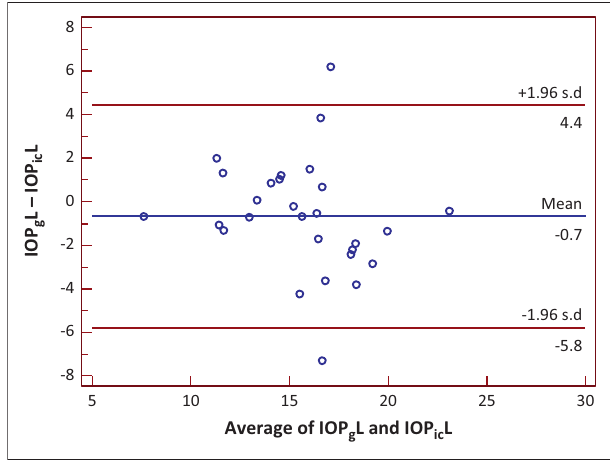
FIGURE 2: A Bland-Altman plot for IOP difference between the two IOP measures is -0.67